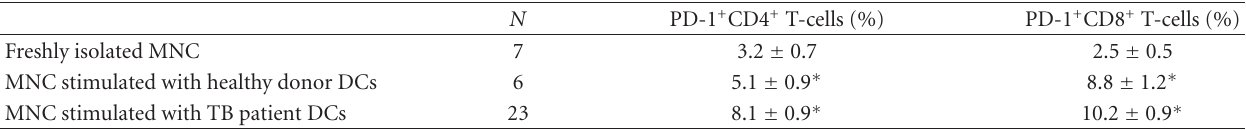
Table 1: The numbers of PD-1 + CD4 + and PD-1 + CD8 + T cells among the healthy donor MNC. N Freshly isolated